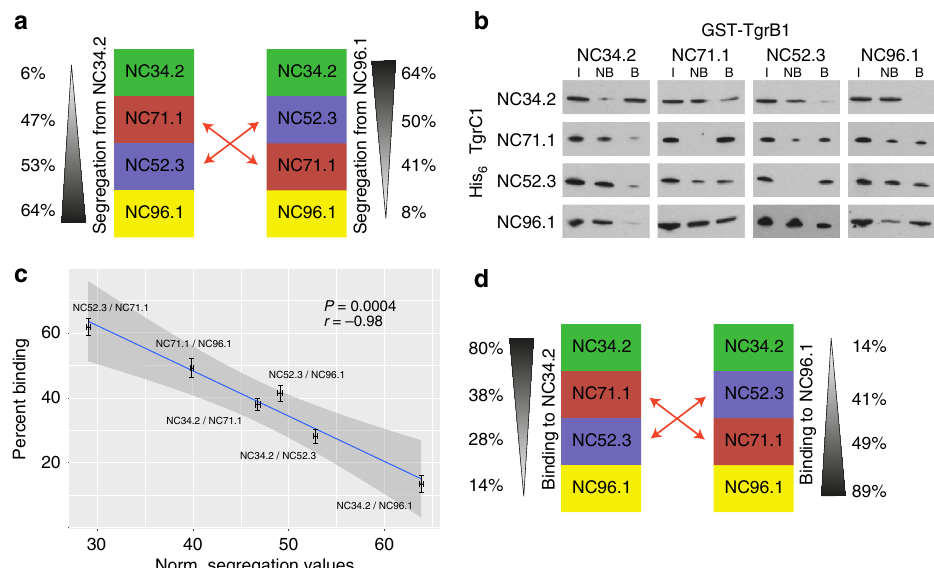
Figure 2 | Segregation between strains can be predicted by TgrB1/TgrC1 binding. ( a ) Strains exhibit non-transitive segregation behaviour. Segregation values between the four strains are not transitive. Numbers on the left show segregation values of mixes containing NC34.2 ordered from top to bottom and numbers on the right show segregation values of mixes containing NC96.1 ordered from bottom to top. Black triangles depict the degree of segregation. Red arrows depict the non-transitive swap of strains NC52.3 and NC71.1. Mean segregation values of all pairings within each hierarchy are significantly different (one-way analysis of variance (ANOVA); P o 2.2 (cid:2) 10 (cid:3) 16 ). ( b ) Immunoprecipitation of bacterially expressed His 6 –TgrC1 and GST–TgrB1 from four different strains. The highest binding was observed between proteins from the same strain. The weakest binding was observed between Tgr proteins from NC34.2 and NC96.1. Varying levels of protein binding were observed between the Tgr proteins from other strains (I ¼ input protein, NB ¼ not bound protein and B ¼ bound protein). ( c ) Scatterplot of binding and segregation values. For each pairwise strain comparison, normalized segregation values were plotted against percent binding. A minimum of six biological replicates were performed for each protein pairing. Y axis error bars depict s.e. of the mean percentage of bound protein in each fraction of the biological replicates, quantified by measuring band intensities on western blots using ImageJ 80 . X axis error bars depict s.e. of the mean normalized segregation value derived from 1000 bootstrapped samples (see methods). Blue line depicts highly negative and significant (Pearson’s product moment correlation: r ¼ (cid:3) 0.98, P ¼ 0.0005) correlation between segregation values and protein binding for mixes of four chosen strains (gray shading: the 99% confidence envelope). Self-mixes are excluded. ( d ) Strength of binding predicts non-transitive segregation behaviour. Binding is not transitive. Numbers show binding of the Tgr proteins. Black triangles depict the strength of binding. Red arrows depict the non-transitive swap of strains NC52.3 and NC71.1. This pattern mirrors the non-transitive behaviour of the segregation values (shown in panel a ). Mean binding values between each pairing in the hierarchy are significantly different (one-way ANOVA; P o 2.2 (cid:2) 10 (cid:3) 16 using adjusted P value